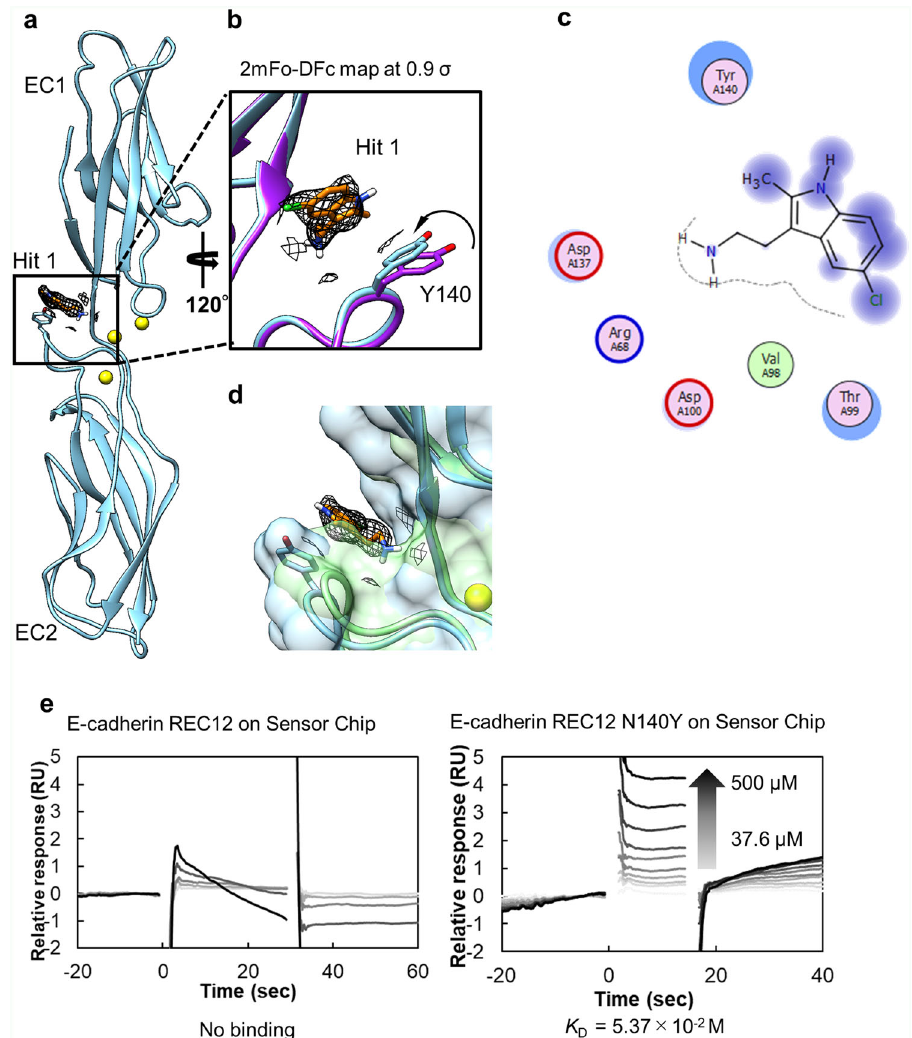
Fig. 2 Hit 1 binds selectively to P-cadherin. a Structure of complex of REC12 with Hit 1. Hit 1 is colored orange. b Region of the Hit 1-binding cavity, illustrating the shift in the side chain of Y140 that occurs upon compound binding. 2mFo-DFc map at 0.9 σ level is shown. The P-cadherin monomer (PDB ID; 4zmz) is superposed (purple). c 2D interaction map of Hit 1 made with FLEV 58 . The reduction of solvent exposure upon Hit 1 binding is indicated by the halo-like disc around the residues. d Superposition of P-cadherin REC12-Hit 1 complex and E-cadherin structure (PDB ID; 2o72, green). e Sensorgram from SPR-based binding assay of WT E-cadherin and E-cadherin N140Y with Hit 1. N =